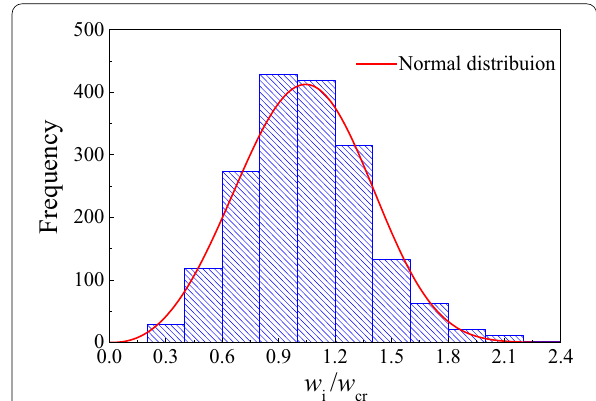
Fig. 13 Probability distribution histogram of w i / w cr.